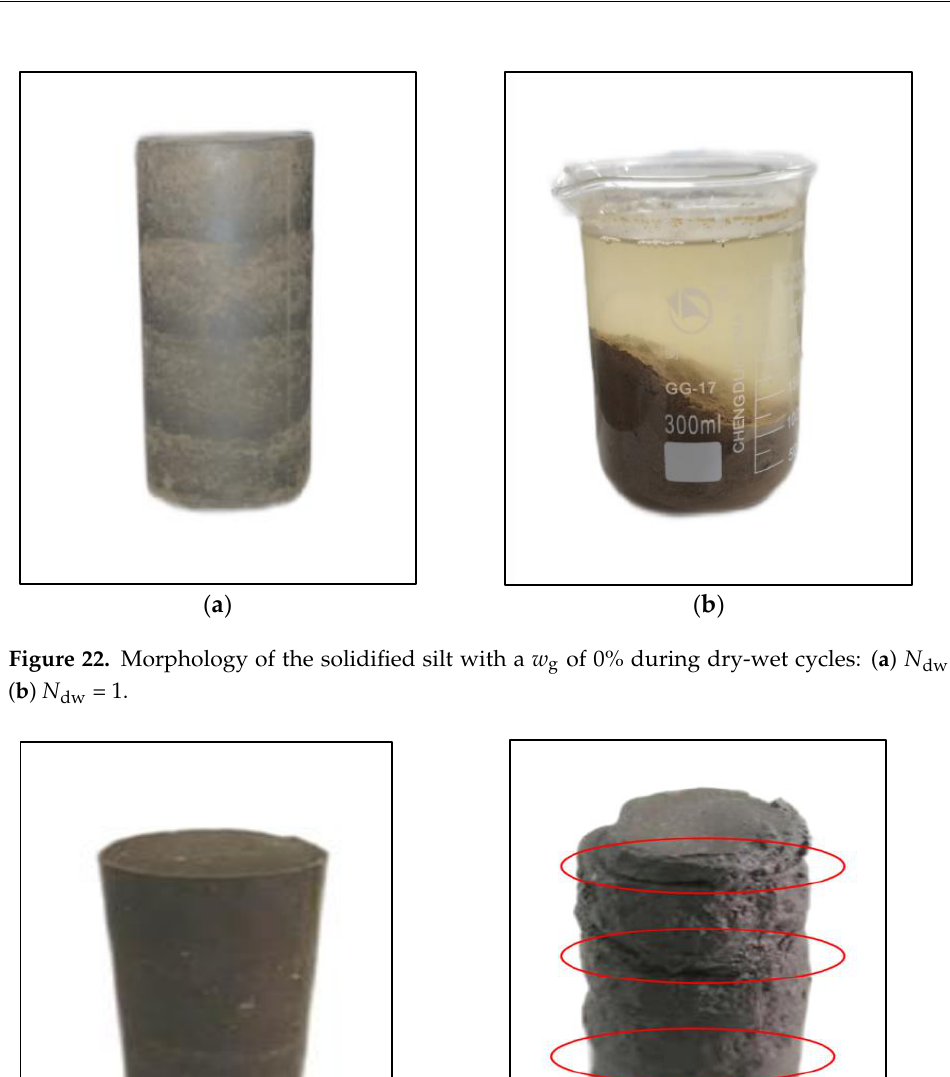
Figure 24. Morphology of the solidified waste silt before and after drying and wetting cycles when w g = 4%: ( a ) N dw = 0, ( b ) N dw = 1, ( c ) N dw = 3.